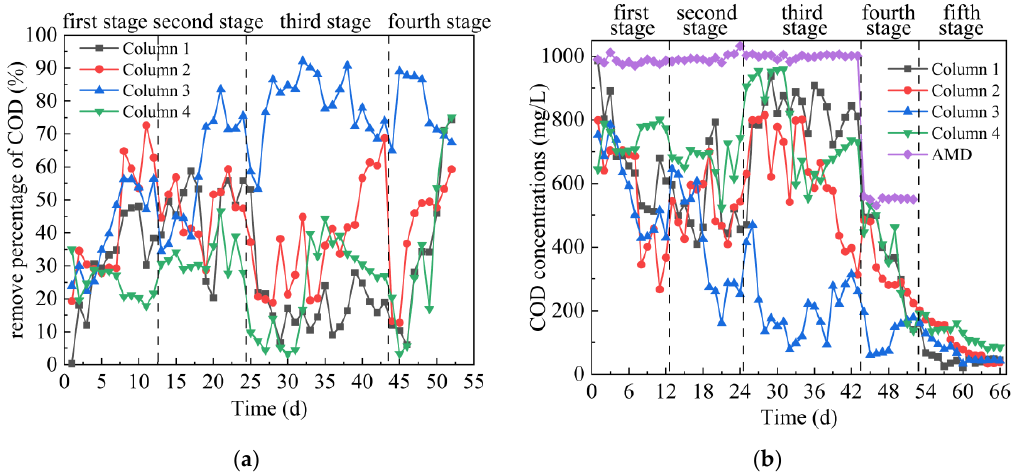
Figure 4. Changes of COD removal effect of SRB combined with Coal Gangue 1–4 to repair AMD. ( a ) COD removal percentage; ( b ) COD concentration.